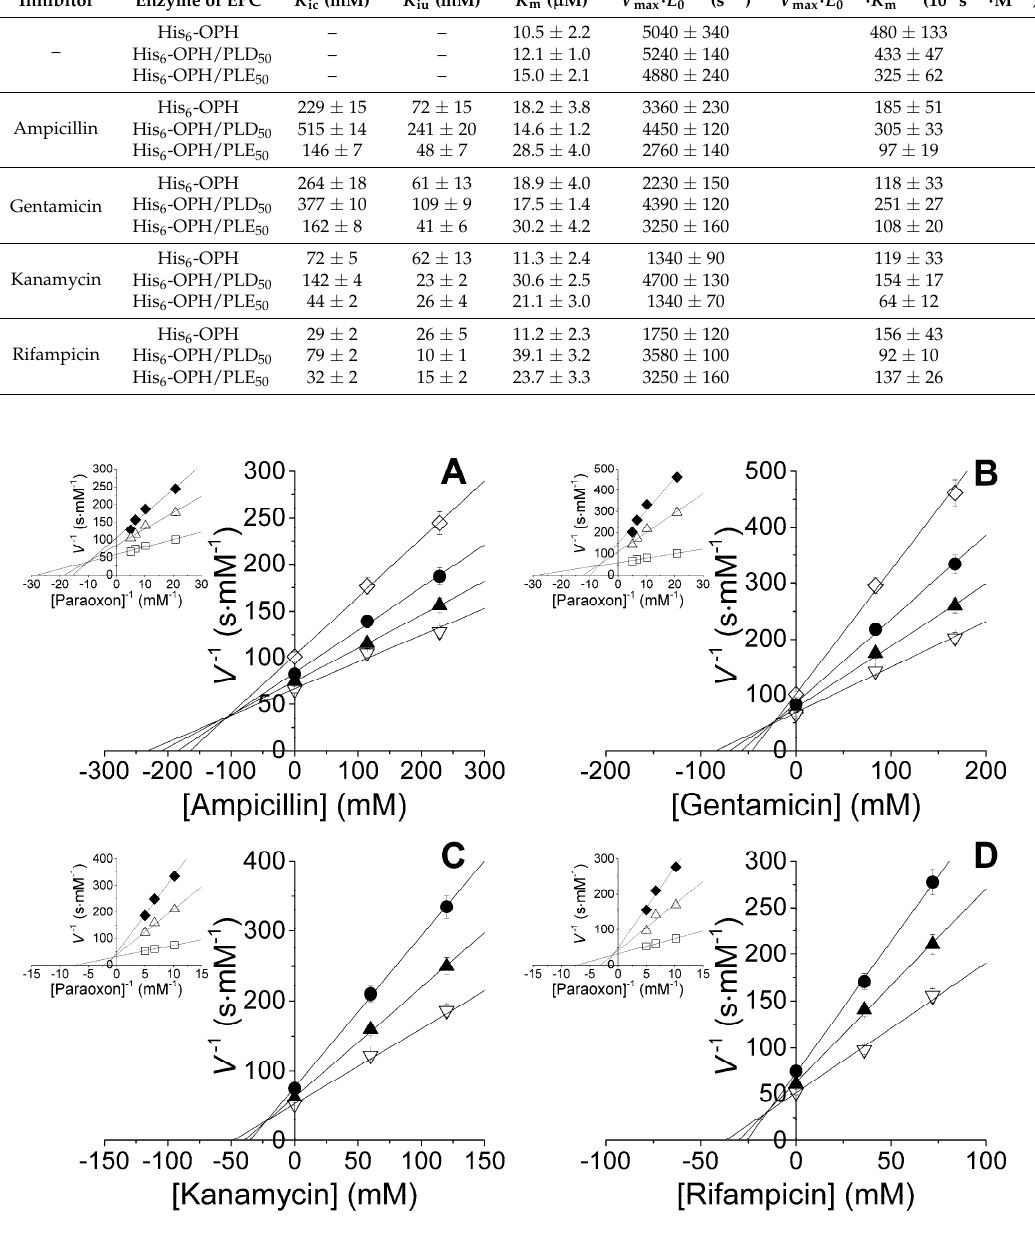
Figure 1. Mixed inhibition of His 6 ‐ OPH by various antibiotics: ( A ) ampicillin ( ♦ —0; ∆ —115 and □ —229 mM); ( B ) gentamicin ( ♦ —0; ∆ —84 and □ —168 mM); ( C ) kanamycin ( ♦ —0; ∆ —60 and □ —120 mM); and ( D ) rifampicin ( ♦ —0; ∆ —36 and □ —72 mM). Paraoxon concentration was 0.05 ( ◊ ), 0.1 ( ● ),